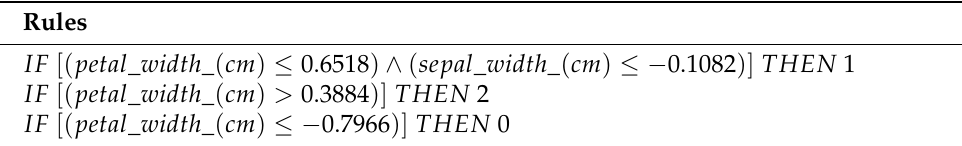
Table A19 shows the final rule set for the Iris dataset inducted by ECLAIRE. Table A19. Final rule set for the Iris dataset generated by ECLAIRE.